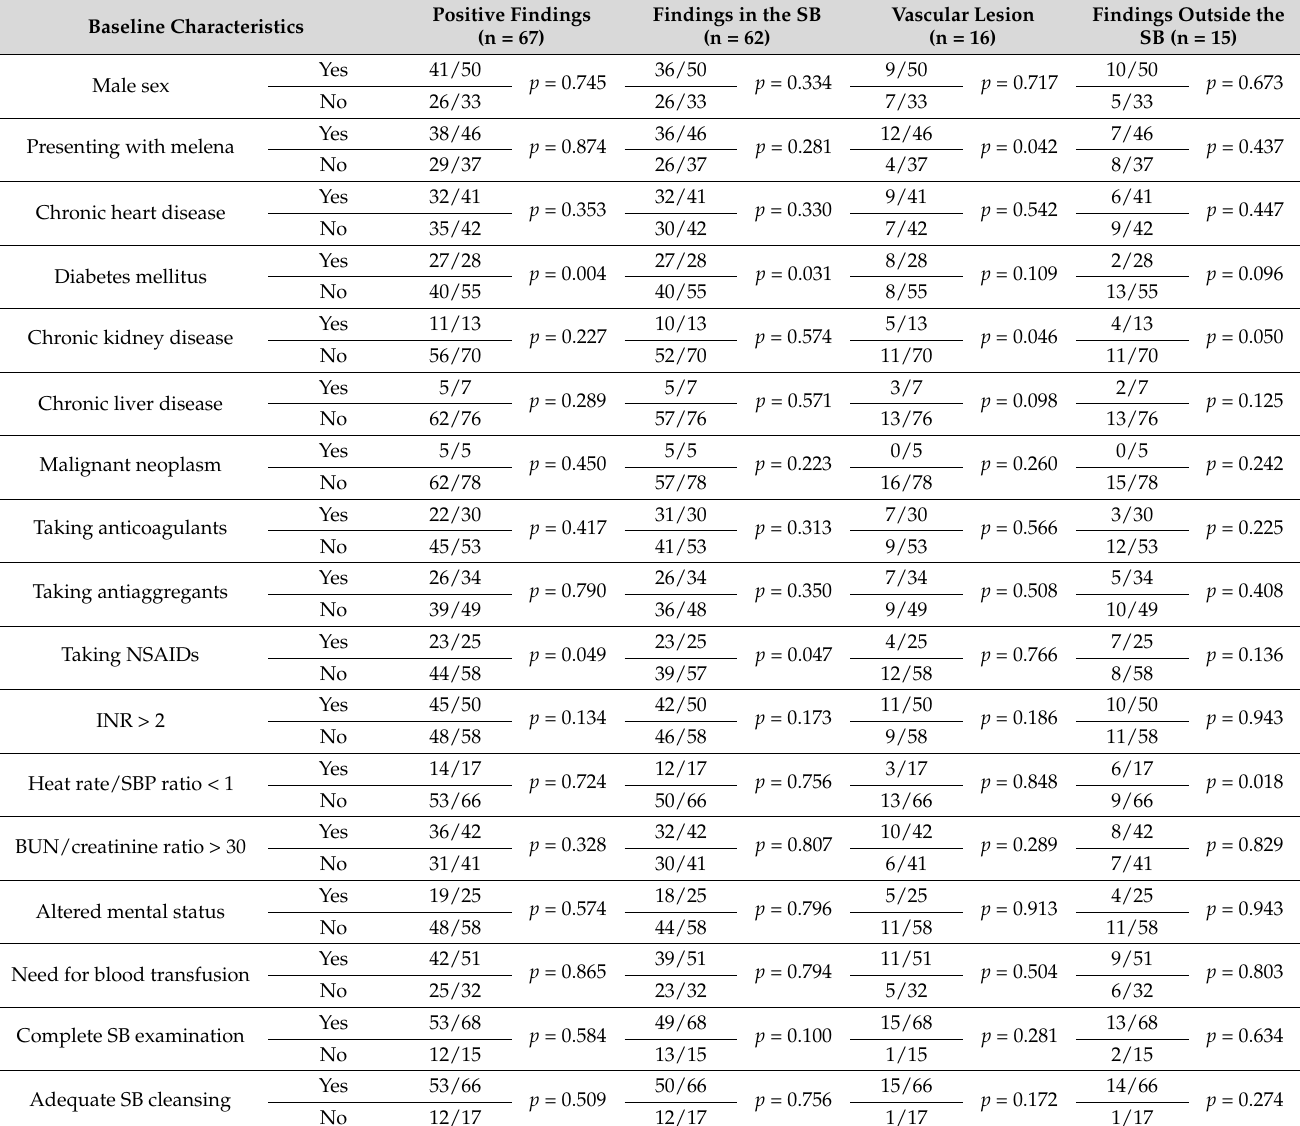
Table 2. Comparison of characteristics among patients with positive findings in small-bowel capsule endoscopy (SBCE), submitted to endoscopic or surgical therapy, and presenting rebleeding (univariate